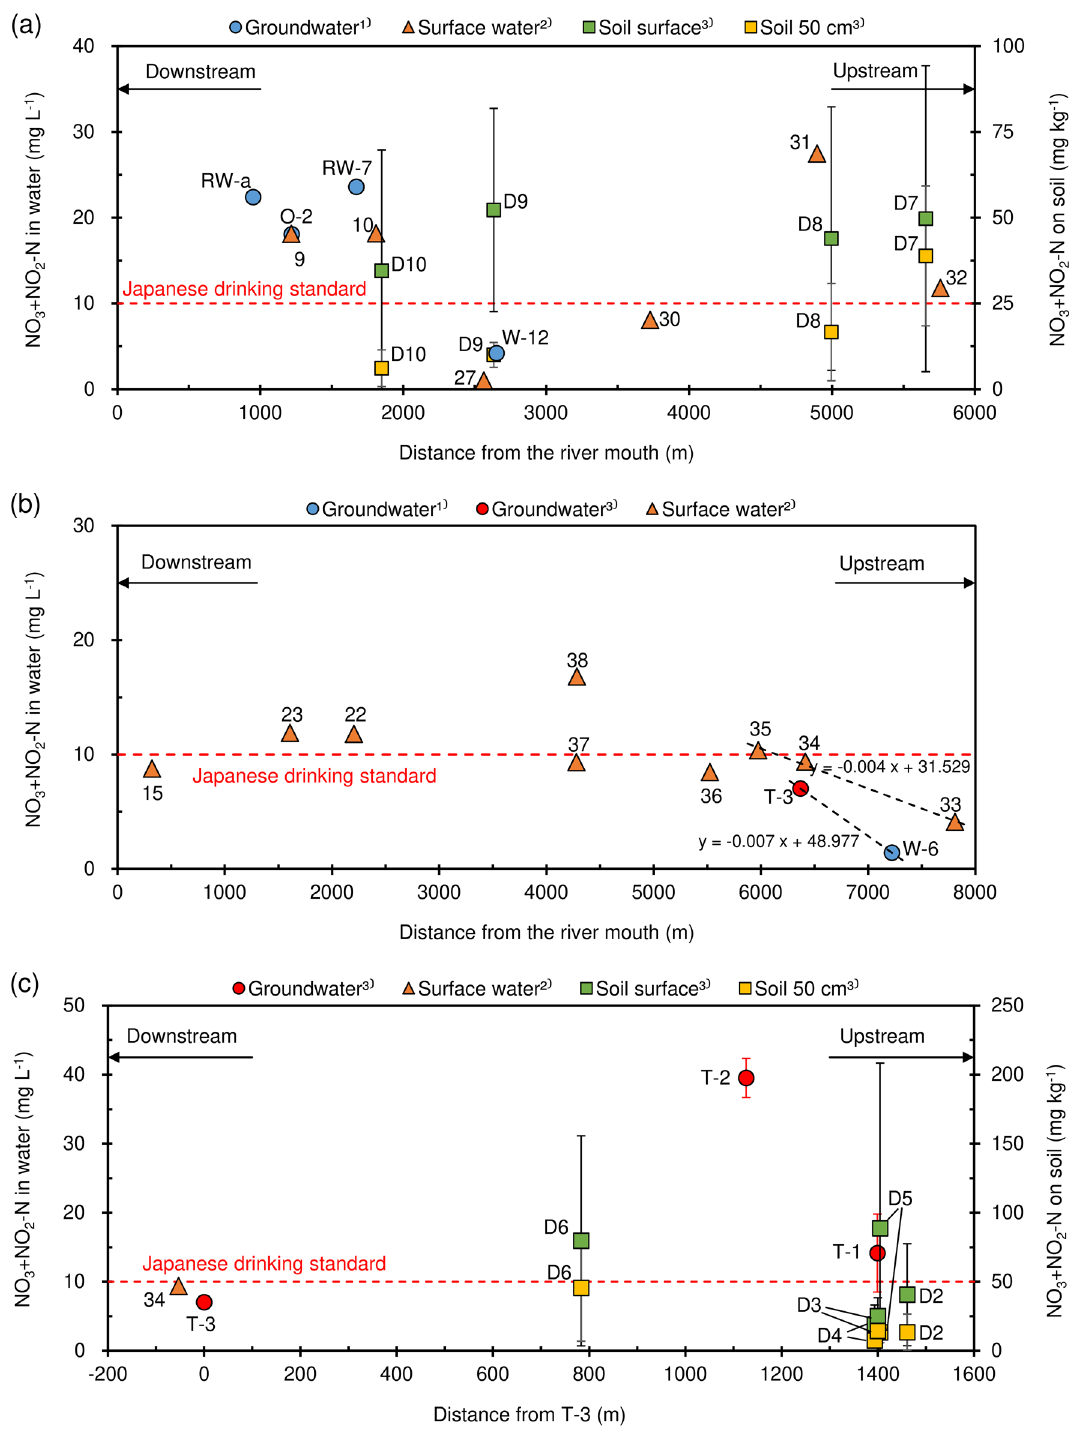
Figure 9. Distribution of nitrate concentration in soil, groundwater, and surface water ( a ) Nishikawa River, ( b ) Yuegawa River, and ( c ) LWDS and downstream. (1) Nakagawa et al. 17 , (2) Amano et al. 19 , (3) this